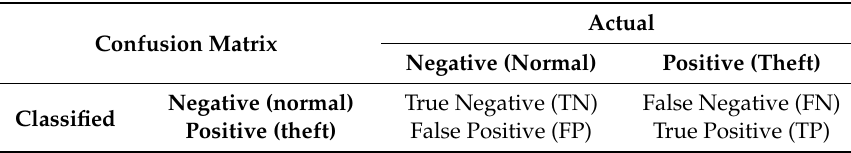
Table 3. Confusion